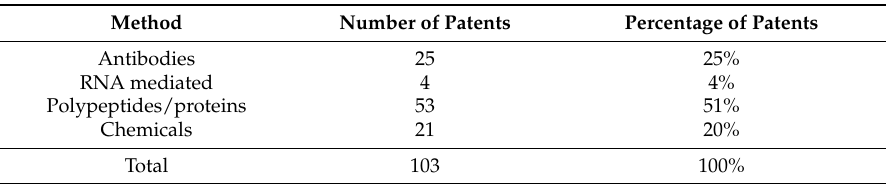
Table 3. Types of compounds identified to modulate Wnt